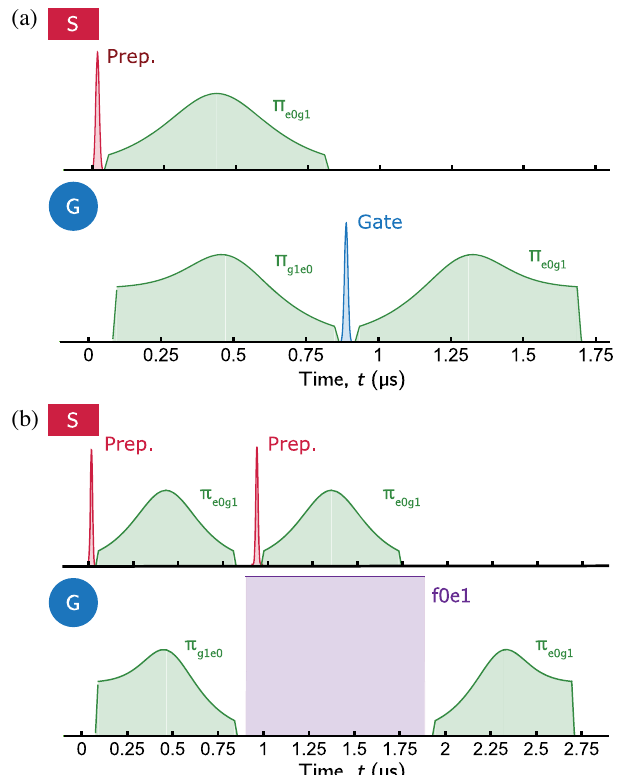
FIG. 13. Timing diagram of the pulses applied to the gate qubit ( G , blue circle) and the source qubit ( S , red rectangle) for quantum process tomography of (a) single-photon gates and (b) the CPHASE gate. Depicted are the envelopes of the pulses on the charge line of the source (red) and the gate qubit (blue), as well as the envelopes of the flux pulses driving the j e 0 i ↔ j g 1 i transition with the flux line of the respective coupler (green) and the j f 0 i ↔ j e 1 i transition via the flux line of the coupler of the gate qubit (purple).